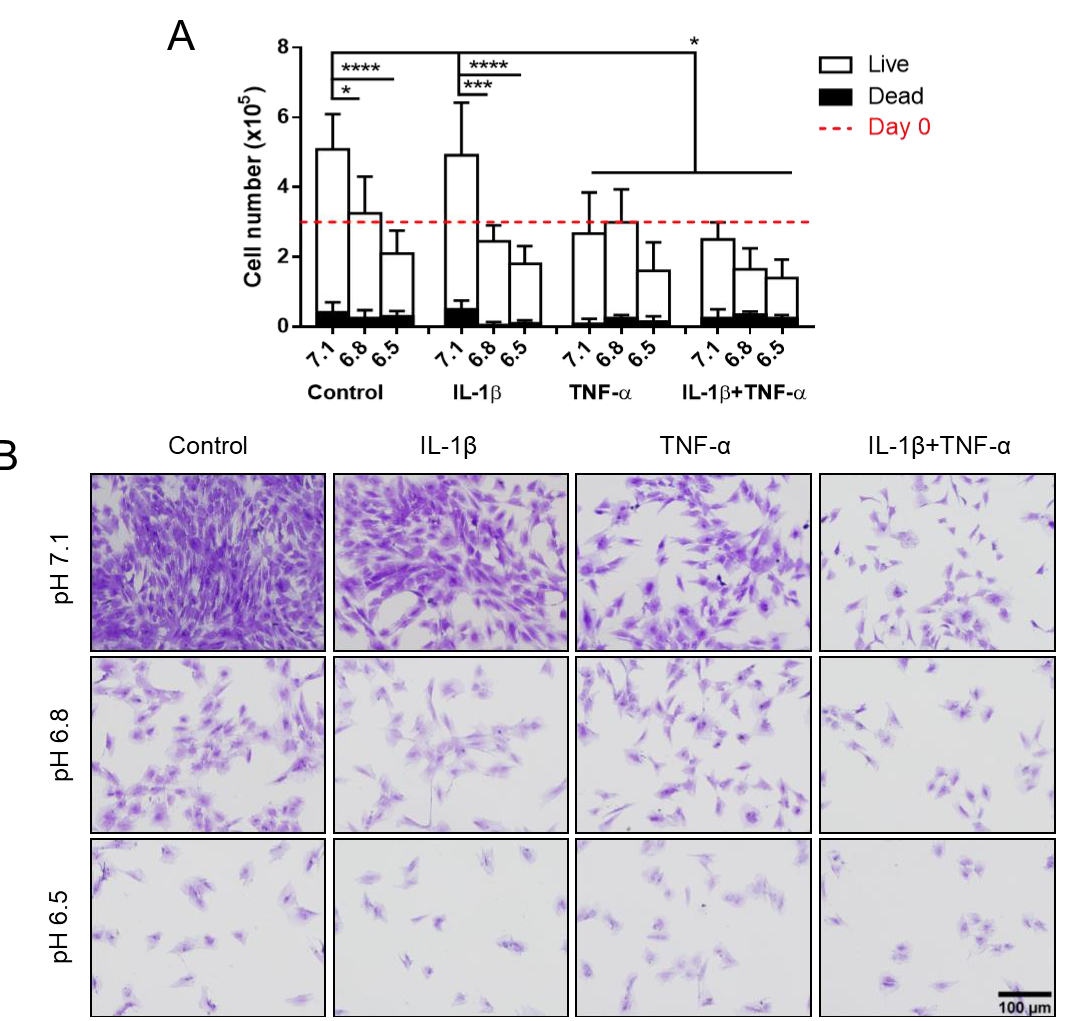
Figure 1. 2D culture effects of pH and inflammatory cytokines on nasal chondrocytes (NCs). ( A ) Viable cell count at day 7 for NCs on 2D tissue culture plastic cultured in pH modified media (pH 7.1, 6.8 and 6.5) either unsupplemented (control) or supplemented with interleukin-1ß (IL1-β), tumour necrosis factor-α (TNF-α) or a combination of both. * ( p < 0.05), *** ( p < 0.001) and **** ( p < 0.0001) indicate significant differences between groups. N = 1 donor, n = 3 samples. ( B ) Crystal violet staining of NCs at day 7. Scale bar is 100 μm.